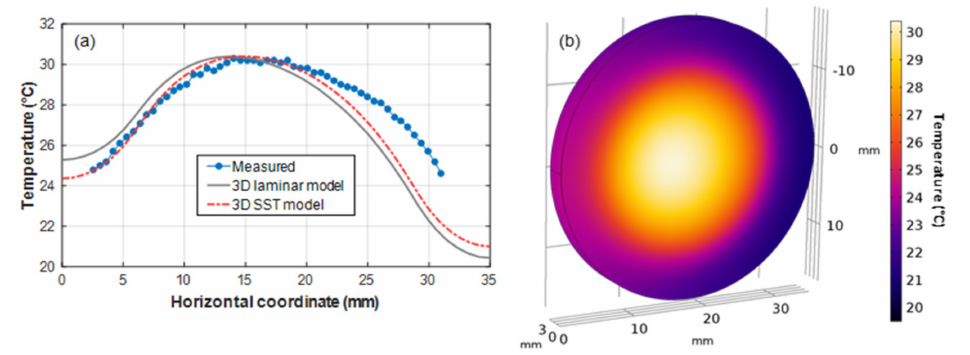
Figure 6. Comparison of measured and modeled temperature profiles in the central dissection line of the front surface of the Ti:Sa crystal (laminar flow model—grey line, SST turbulent model—red dashed line, the measured ones—blue dots ( a ). The 3D temperature distribution in the Ti:Sa crystal in the SST turbulent model ( b